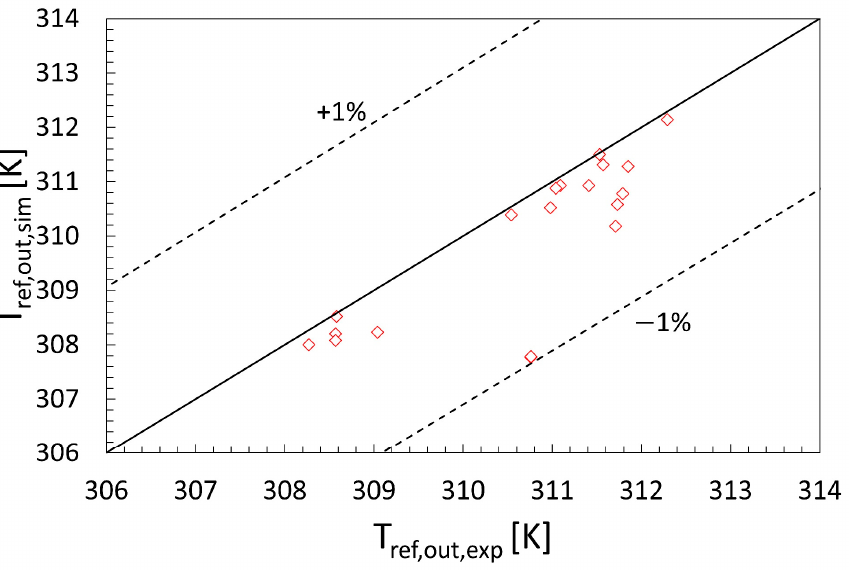
Figure 11. Comparison between the simulated refrigerant outlet temperatures obtained by the numerical model and the corresponding experimental data for different working conditions of the gas cooler. The experimental distribution of the airflow was considered for the simulations.